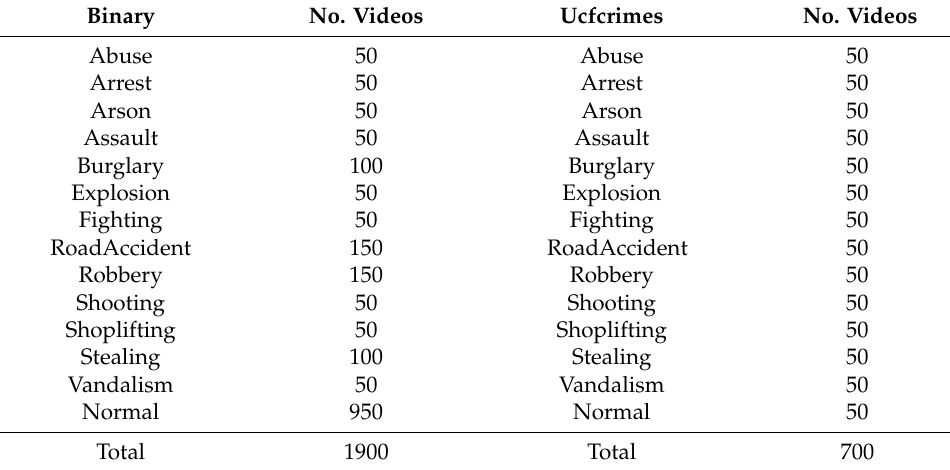
Table 1. Number of videos for Binary and Ucfcrimes datasets.